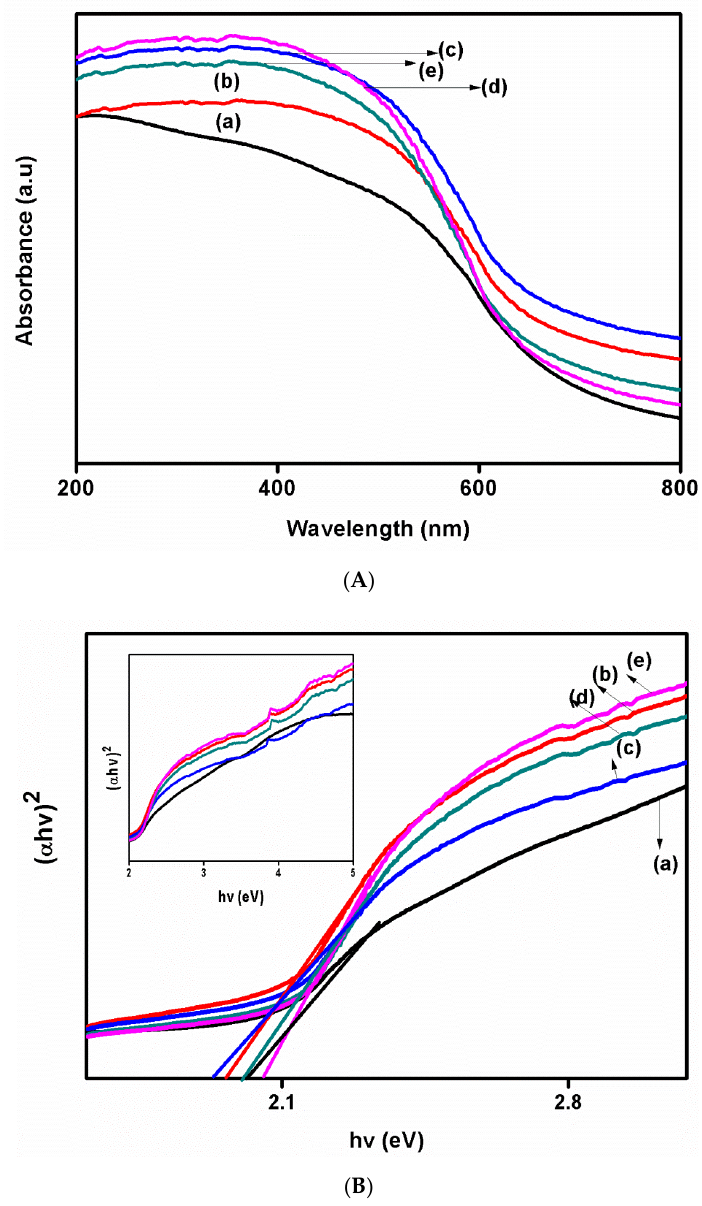
Figure 4. ( A ) UV-DRS spectra of ( a ) Cu 2 O and ( b – e ) GCC 1, 2, 3, and 4. ( B ) Band gap spectra of ( a ) Cu 2 O and ( b – e ) GCC 1, 2, 3, and 4. Cu 2 O and ( b – e ) GCC 1, 2, 3, and